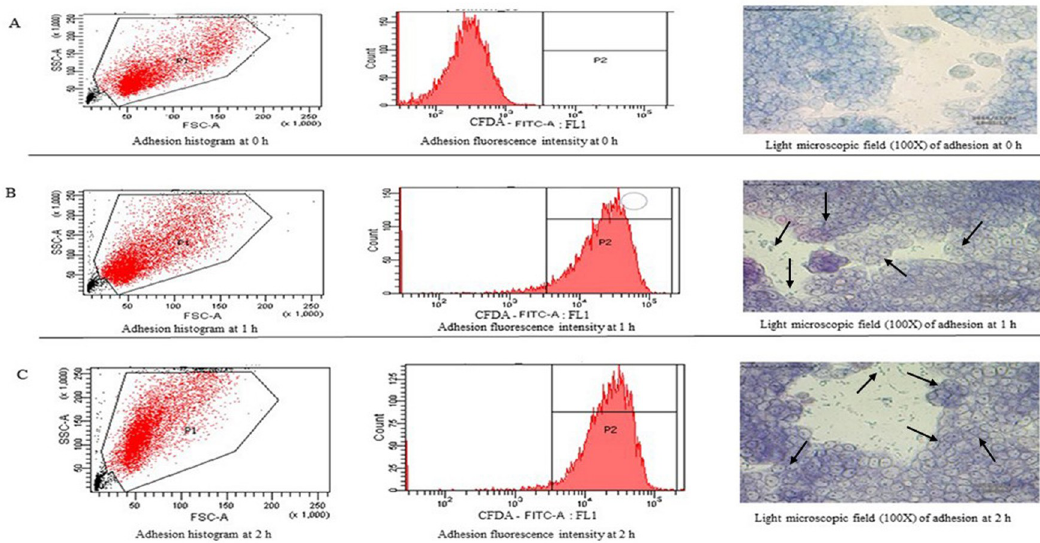
Fig 3. Adhesion efficiency of P . pentosaceus OBK05 by flow cytometry. (A) HT-29 cells co-incubated with CFDA-labeled OBK05 at 0 h, (B) HT-29 cells co-incubated with CFDA-labeled OBK05 for 1 h and (C) HT-29 cells co-incubated with CFDA-labeled OBK05 for 2 h. Arrows indicate that the adhesion of live OBK05 strain was stained with Giemsa dye on HT-29 cells for 1 and 2 h and showed > 100 bacterial counts respectively.